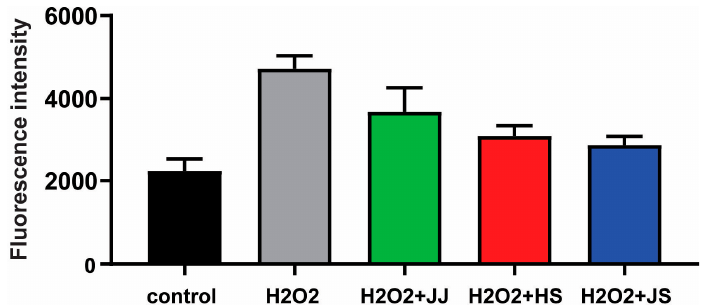
Figure 4. Effects of C. lanceolata extracts on the production of ROS in HepG2 cells. The reuslts are expressed as mean ± SD. The experiment was performed in triplicate.